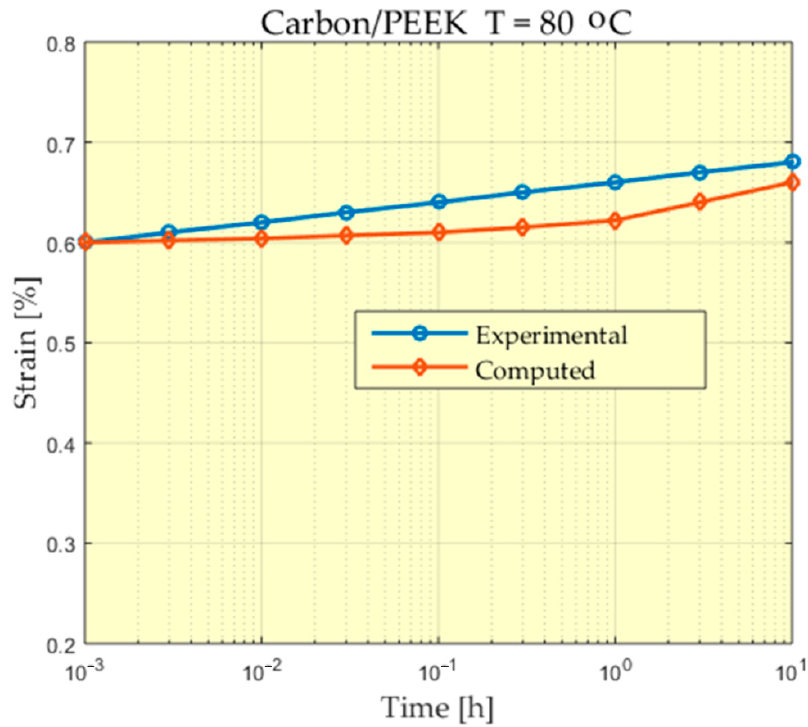
Figure 6. Comparison between experimental and theoretical prediction of creep strain for Car- bon/PEEK subjected to 26 MPa at 80 °C.